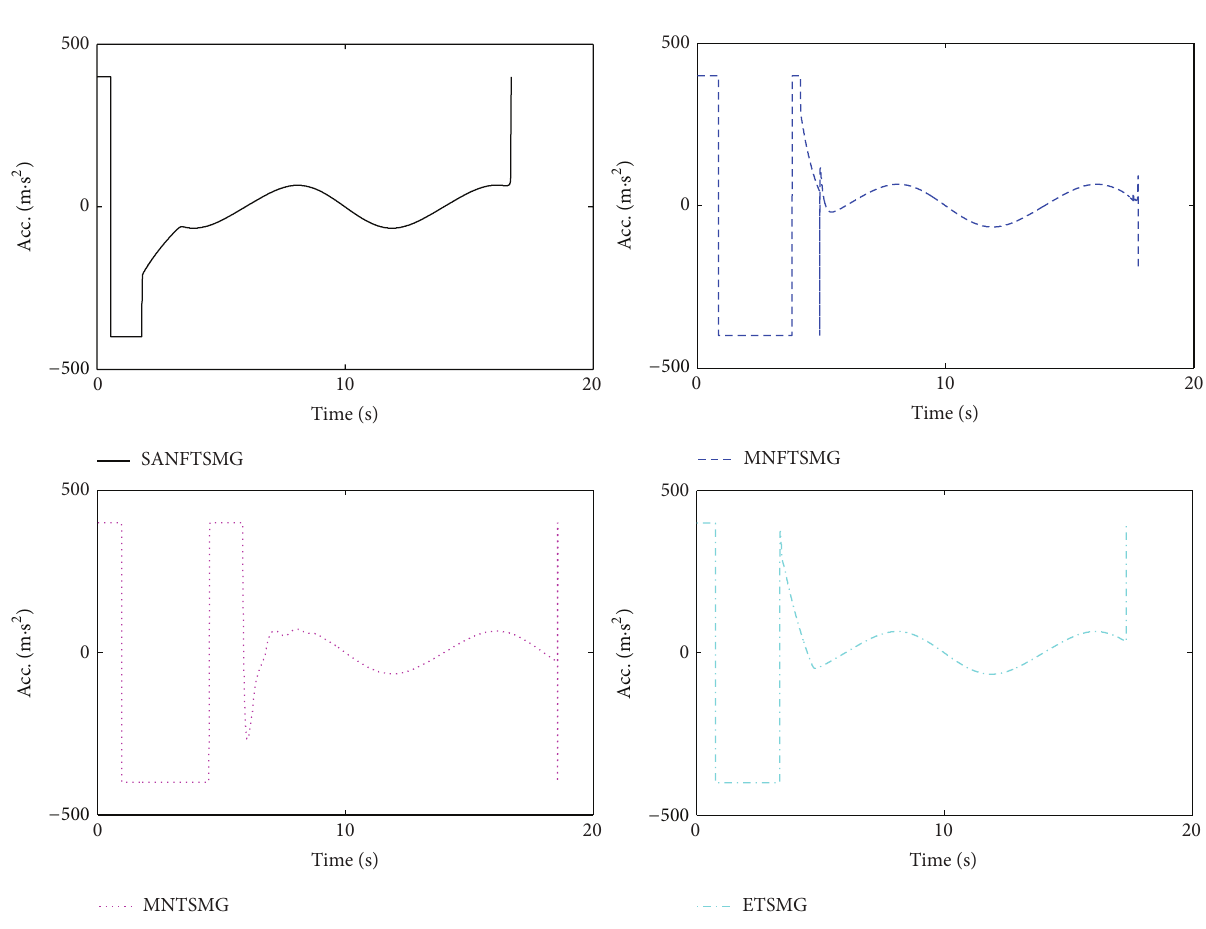
Figure 22: Missile acceleration (Case